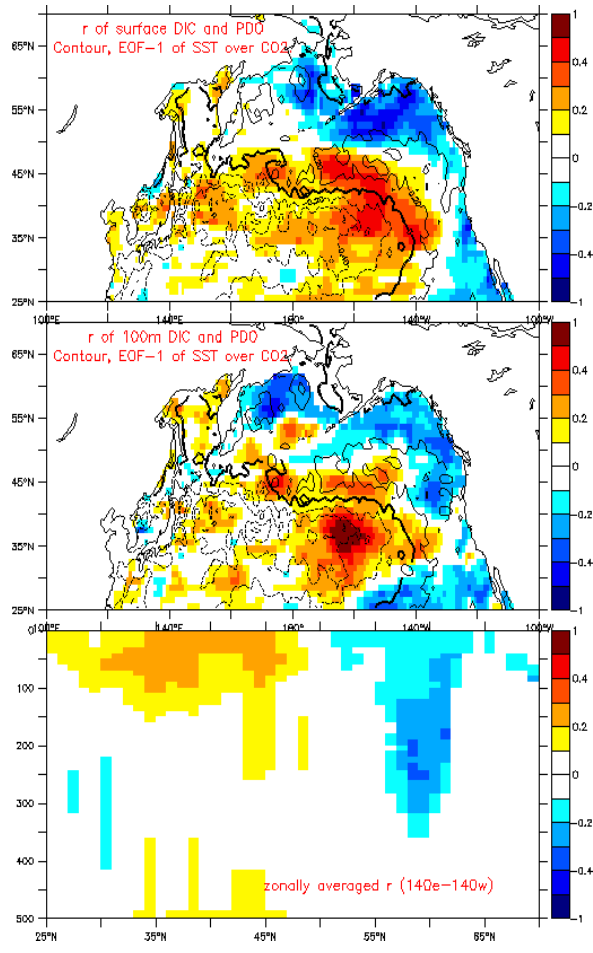
Fig. 14. Correlations between DIC and PDO shown for the (top- panel) surface and for (middle-panel) 100m depth level. Spatial Figure 14: Correlations between DIC and PDO shown for the (top-panel) surface and for (middle- 4 pattern of SST from CEOF-1 of SST and CO 2 flux is overlaid as panel) 100m depth level. Spatial pattern of SST from CEOF-1 of SST and CO 2 flux is overlaid as 5 contours. Bottom panel shows the vertical section of correlations contours. Bottom panel shows the vertical section of correlations averaged over a zonal dimension of 6 averaged over a zonal dimension of 140 ◦ E to 140 ◦ W. Correlations 140 0 E to 140 0 W. Correlations significant at 90% confidence interval are shaded. 7 significant at 90% confidence interval are 8